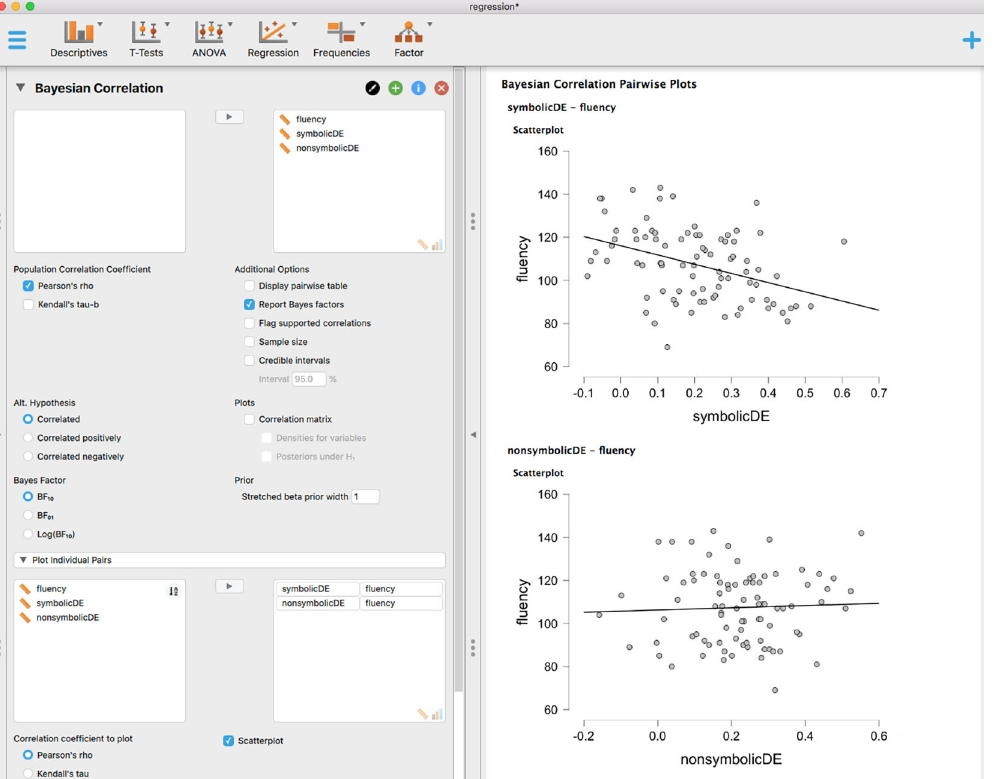
To perform the Bayesian linear regression, we click the “Regression” button and select “Bayesian Linear Regression”. We then move the fluency variable to the “Dependent Variable” box and we move both the symbolicDE and nonsymbolicDE variables to the “Covariates” box. We will leave the basic defaults in place except for two. First, select “Posterior summary” under “Output”. Also, we will select one more option that is found in the “Advanced Options” section, but will actually simplify our discussion for this tutorial. Under “Model Prior”, select “Uniform”. The output can be seen in Figure